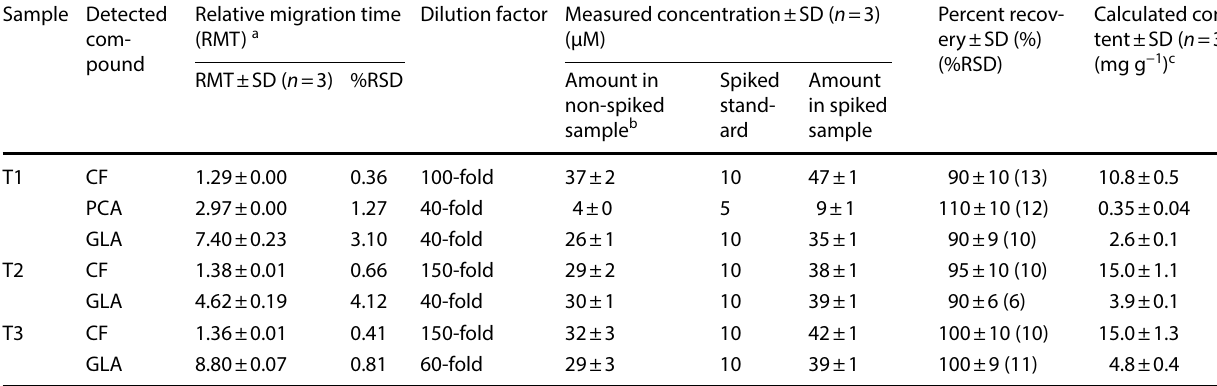
a Relative migration time (RMT): ratio of migration time of compound to migration time of internal standard (0.15 mM tyramine) b Instrumental LODs of 6 µM for PHPA, 2 µM for PCA, 4 µM for PHBA, 19 µM for CFA,12 µM for DHPA, and 7 µM for THBA c Not Detected (< LOD of analysis; 0.2 and 0.3 mg PCA g −1 dry weight of tea leaves for T2 and